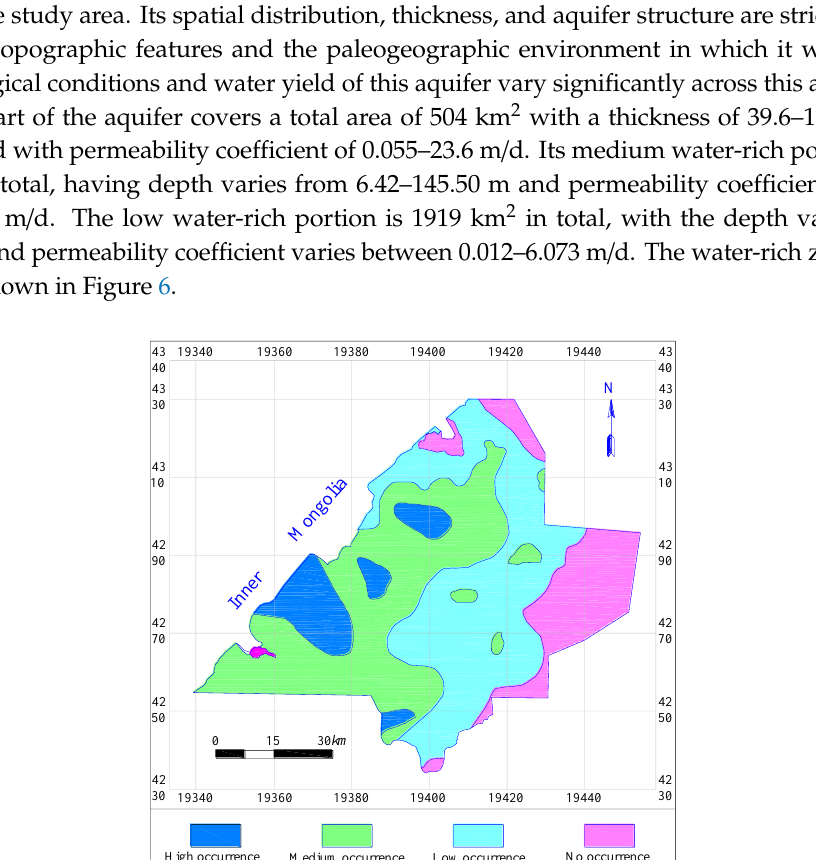
Figure 6. Water-rich zoning map of aquifers (Xi'an geodetic coordinate system 1980; in km).